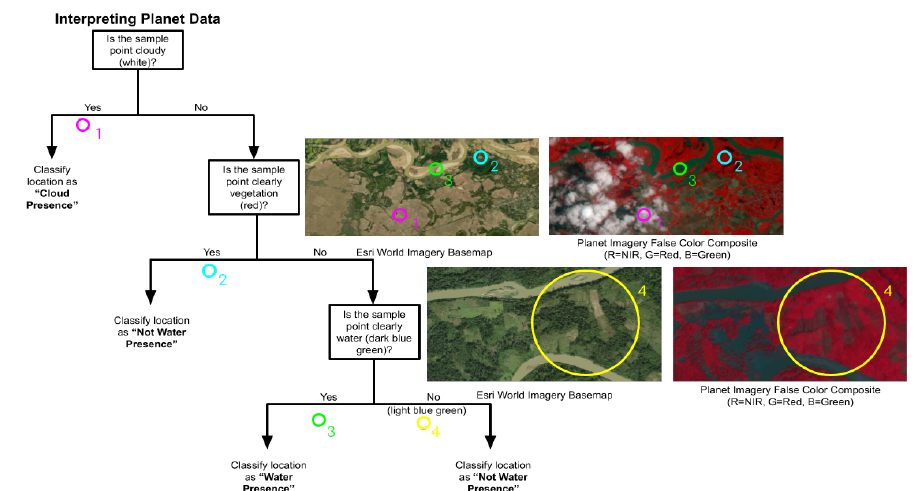
Figure 3. Interpreter decision tree utilized for sampling imagery. Circle numbers 1–4 (pink, blue, green, yellow) provide visual representation of decision points for sample classification